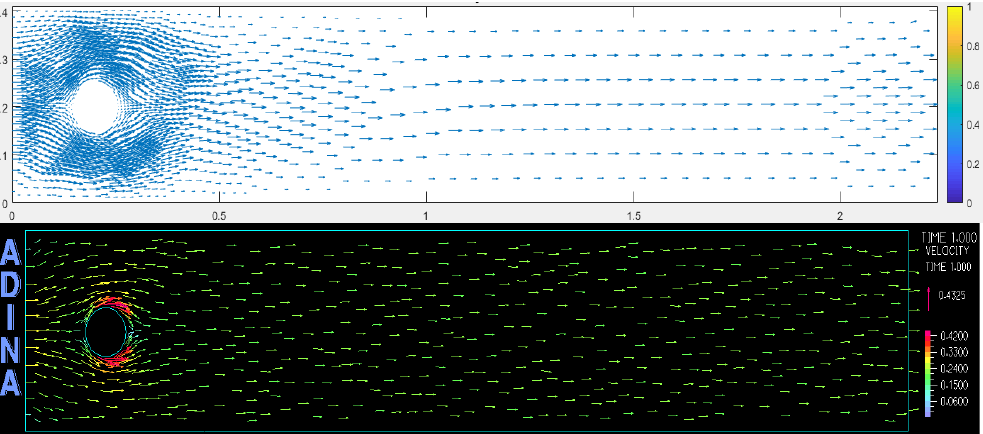
Figure 5. Velocity vector solution by P 1 − Bubble / P 1 ( above ) and velocity vector solution computed by the ADINA system ( below ) with α 1 = α 2 = 10 − 6 .